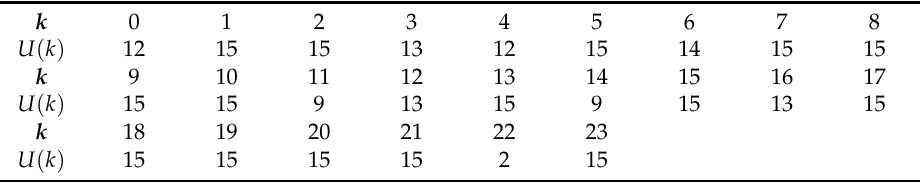
Table 6. Optimal production plan yielded by the simulated annealing (SA)